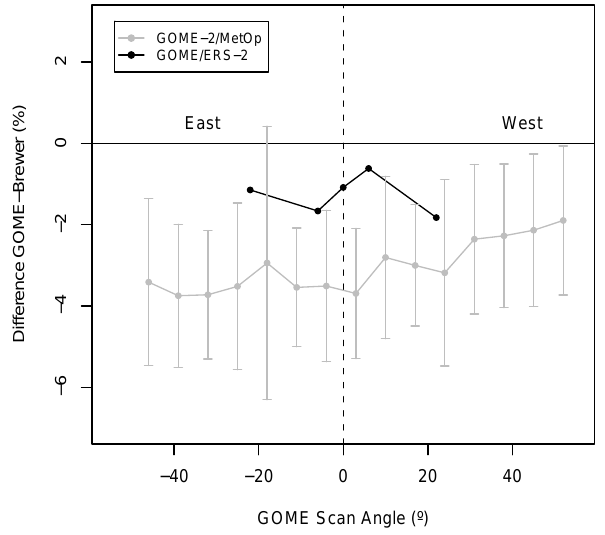
Fig. 3. Dependence of GOME-Brewer relative differences with re- spect to the GOME scan angle for the “Iberian Peninsula” dataset.